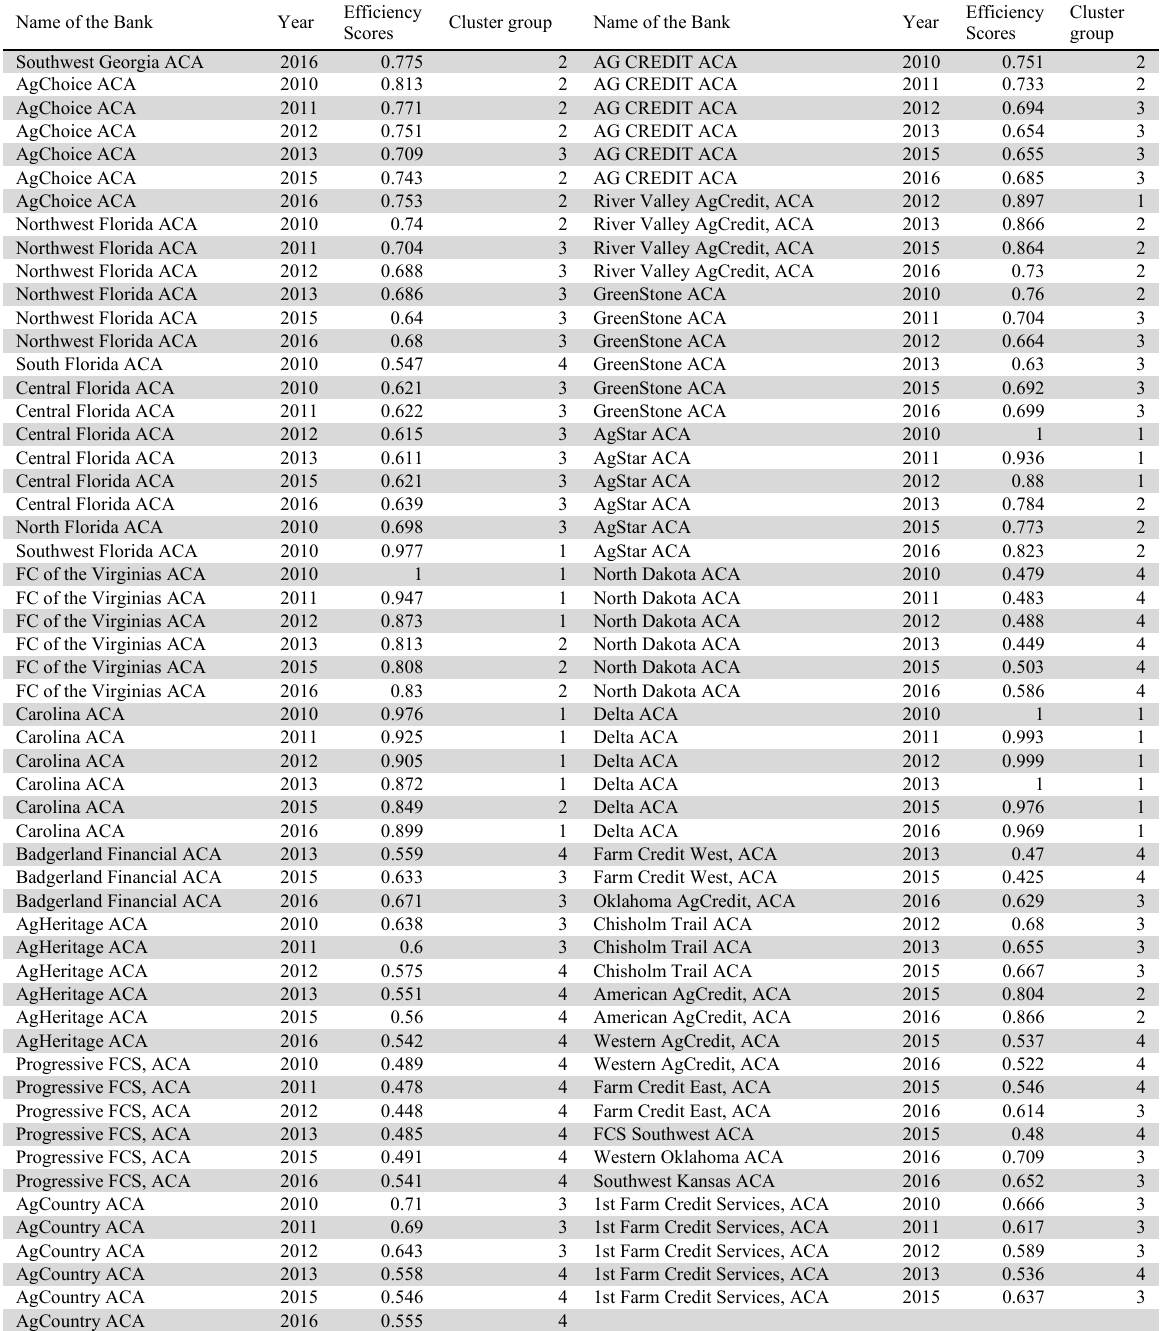
Efficiency Measure (2010-2016) (Continued) Name of the